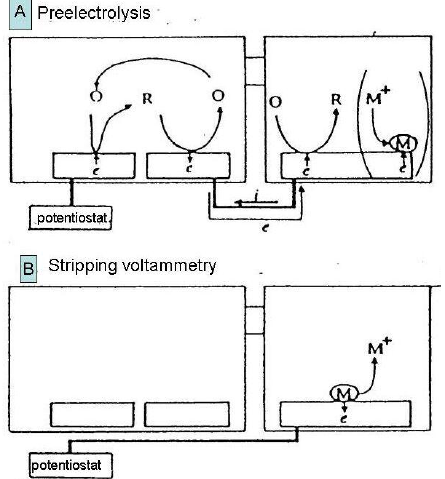
Figure 12. Principle of substitutional stripping analysis [132]. A—transfer of redox cycling to the right compartment during preelectrolysis step; B—electrochemical stripping of metal deposited on